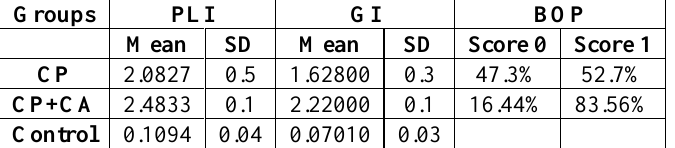
Table 1:The mean values and Standard deviation of PLI and GI and the percentages of sites with BOP among the groups